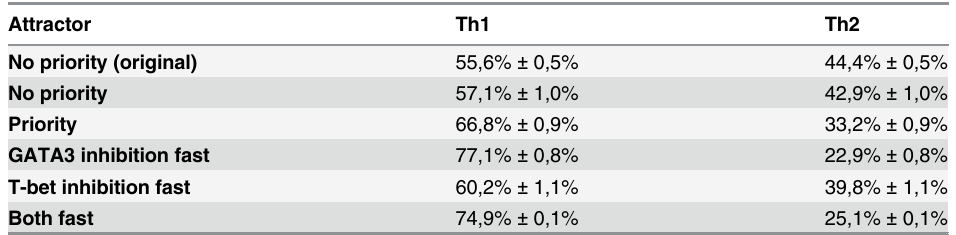
Table 3. Results of the canalisation analysis for the Th network.